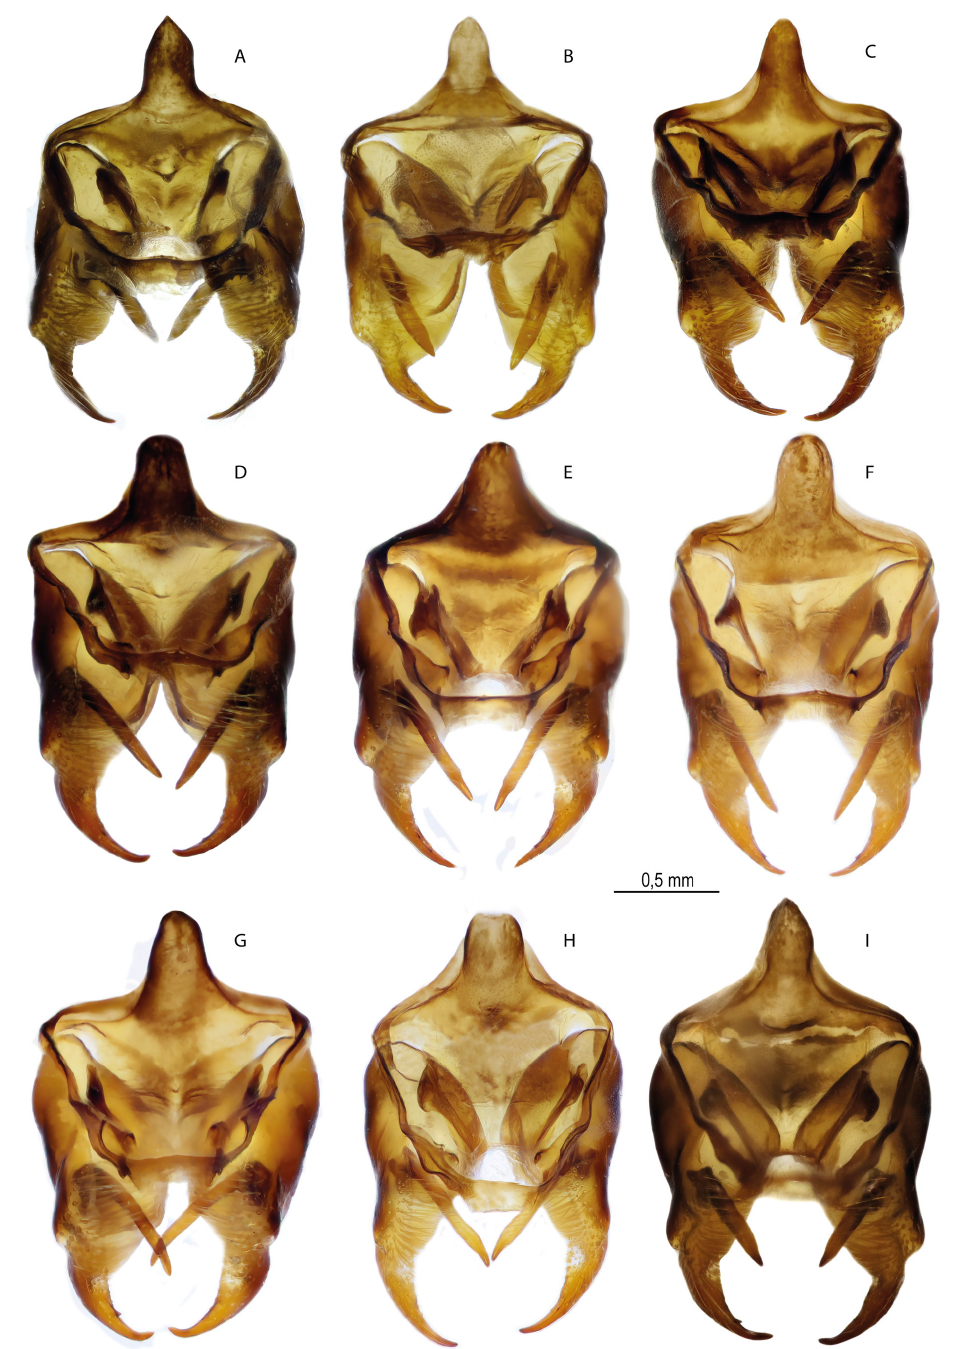
Fig. 16. Male genitalia (without aedeagus) in dorsal projection. A–C . Melitaea shahvarica sp.